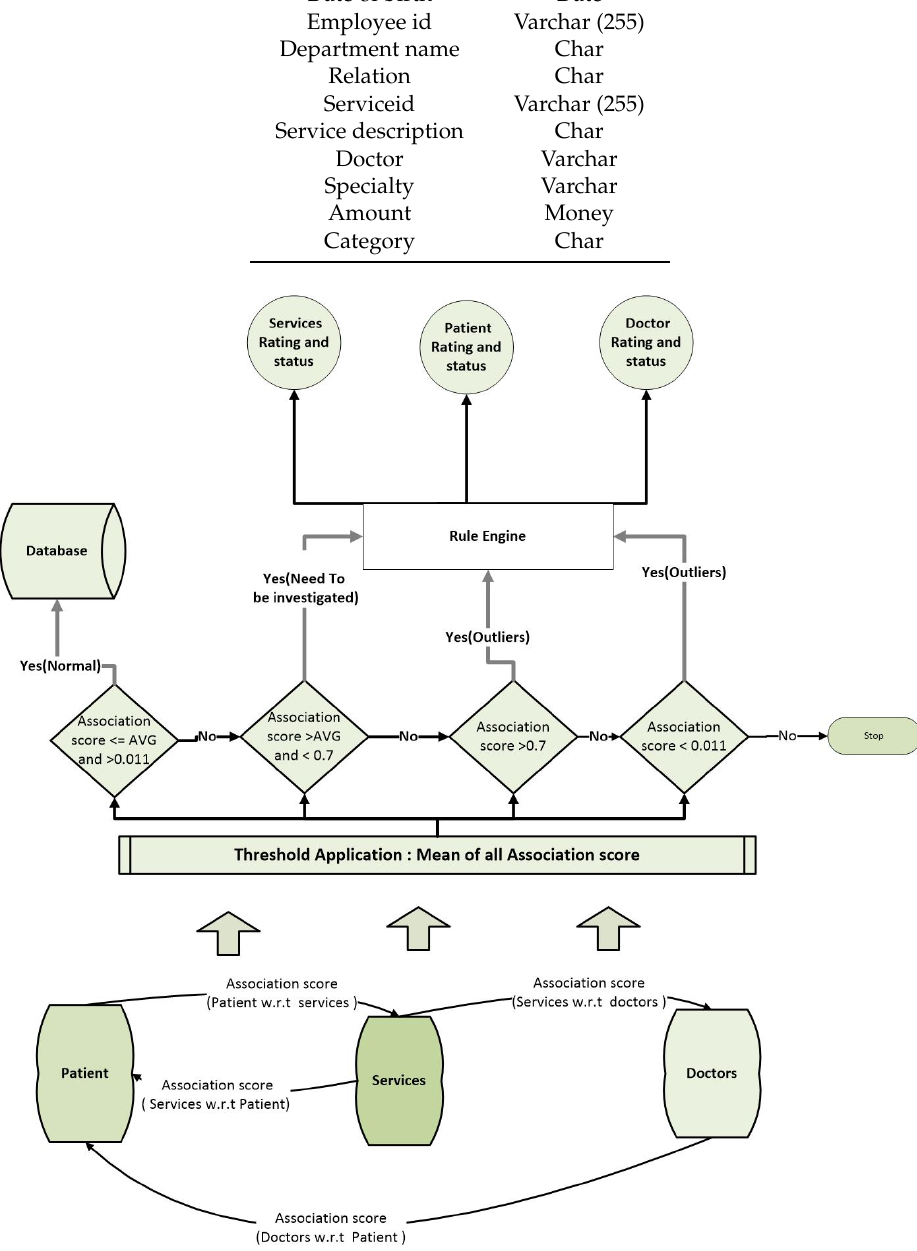
Figure 2. This figure depicts functionality of proposed fraud detection model. First association scores are computed among services, doctors and patients then based on association scores cases are forwarded to Rule engine for further